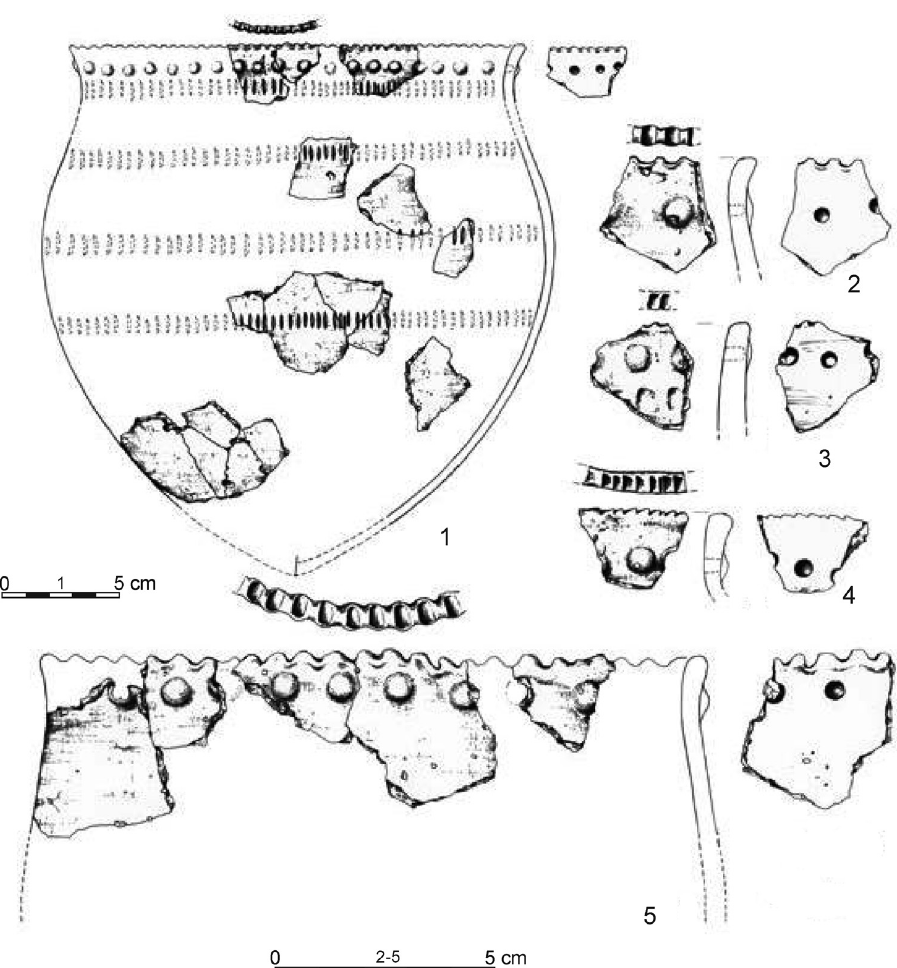
Figure 7: Para - Neolithic pottery ( Neman culture ) from the site 1 at Gr ą dy Woniecko ( 1 – 5 ) ( after Wawrusiewicz et al., 2017 )